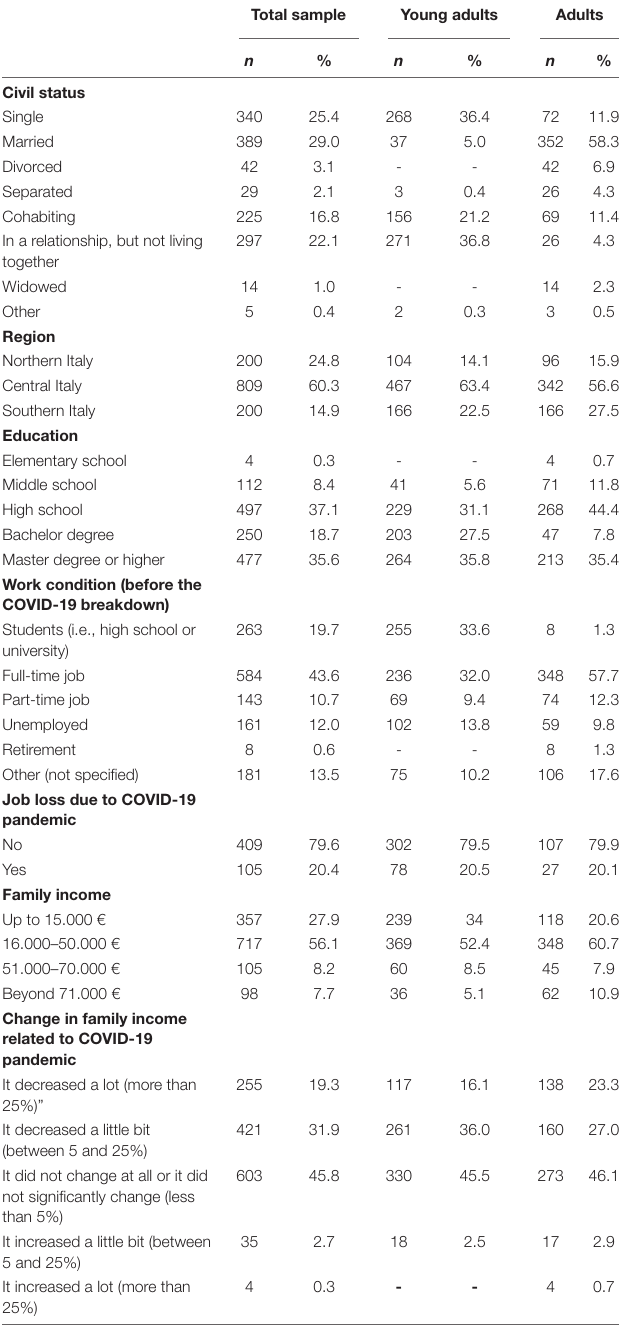
TABLE 1 | Sociodemographic characteristics of the